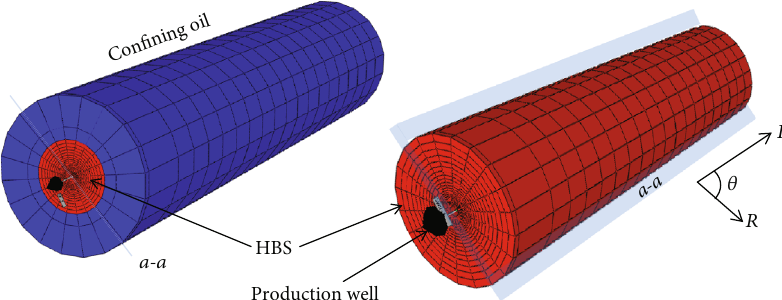
Figure 2: Numerical model and grid block distribution. The model boundary condition of the model is the same with experimental condition, with constant con fi ning pressure and temperature. No mass exchange occurs between the con fi ning oil and the